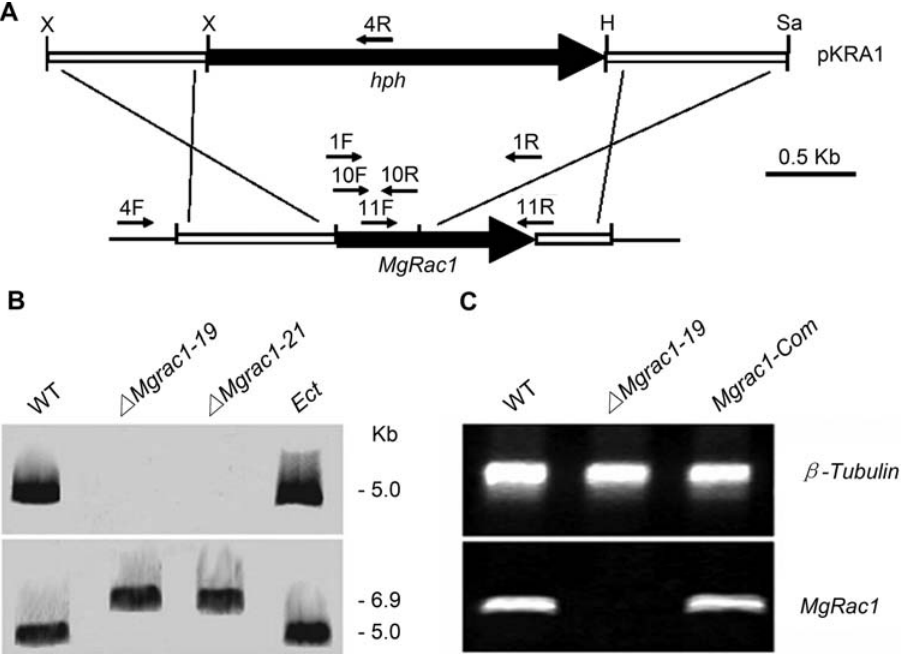
Figure 1. Construction and confirmation of the Mgrac1 deletion mutant. (A) Restriction map of the MgRac1 genomic region and deletion construct pKRA1. Thick arrows indicate orientations of the MgRac1 and hygromycin phosphotransferase ( hph ) genes. The restriction enzymes are abbreviated as X ( Xho I), H ( Hin dIII), and Sa ( Sac I). The Mgrac1 deletion construct pKRA1 contained the homologous sequences flanking the hph gene to replace the first 525-bp of the MgRac1 ORF. Primers 4F and 4R (Table 4) were used for screening the Mgrac1 deletion mutants. (B) Total genomic DNA samples (5 m g per lane) isolated from WT (wild-type strain 70-15), D Mgrac1-19 (Mgrac1 deletion mutant), D Mgrac1-21 (Mgrac1 deletion mutant), and Ect (Ectopic transformant) were digested with Pst I and subjected to Southern blot analysis. The first probe, a 525-bp PCR fragment amplified from the genomic DNA of wild-type strain 70-15 using primers 10F and 10R (Table 4), is exactly the MgRac1 fragment replaced by the 2.6-kb hph gene and detects only the WT and Ect (top panel). The same blot was then stripped and re-hybridized with a 673-bp probe amplified from the 70-15 genomic DNA by primers 11F and 11R (Table 4) and this probe detects both WT and mutant DNA fragments, with the two deletion mutants showing a larger fragment due to the gene replacement (bottom panel). (C) Total RNA samples (approximately 1 m g per reaction) isolated from mycelia of WT, D Mgrac1-19 and Mgrac1-Com (MgRac1 complementary transformant) were subjected to RT-PCR using MgRac1 gene-specific primers 1F and 1R (Table 4). The RT-PCR product is a 600-bp fragment in WT and Mgrac1-Com as predicted, but is missing in the deletion mutant D Mgrac1-19 .